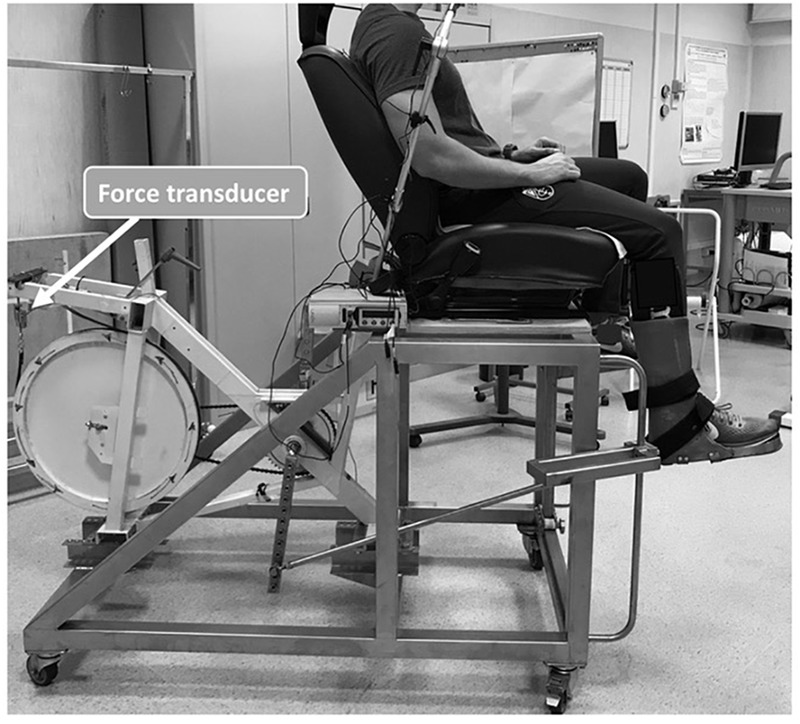
Photographic representation of participant’s positioning on the knee extension ergometer. The load-cell to calculate mechanical power is indicated by the arrow.